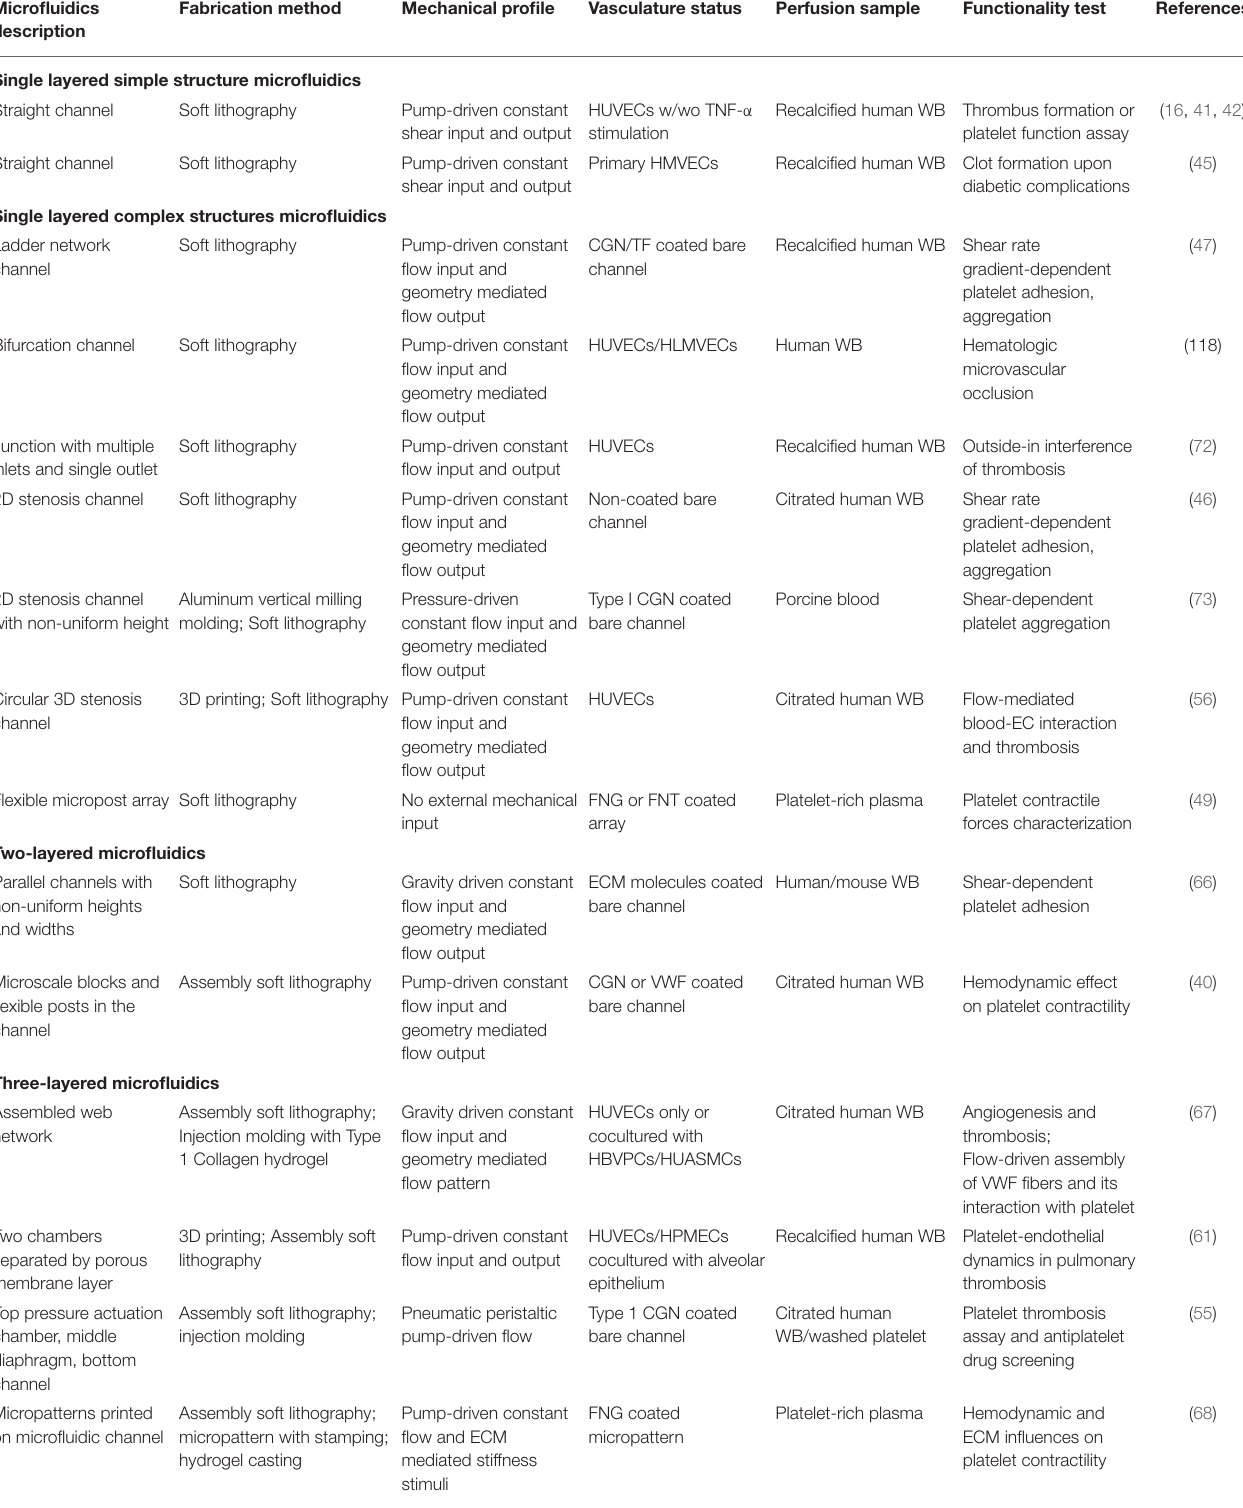
TABLE 1 | Summary of microfluidic models for platelet mechanobiology in thrombotic